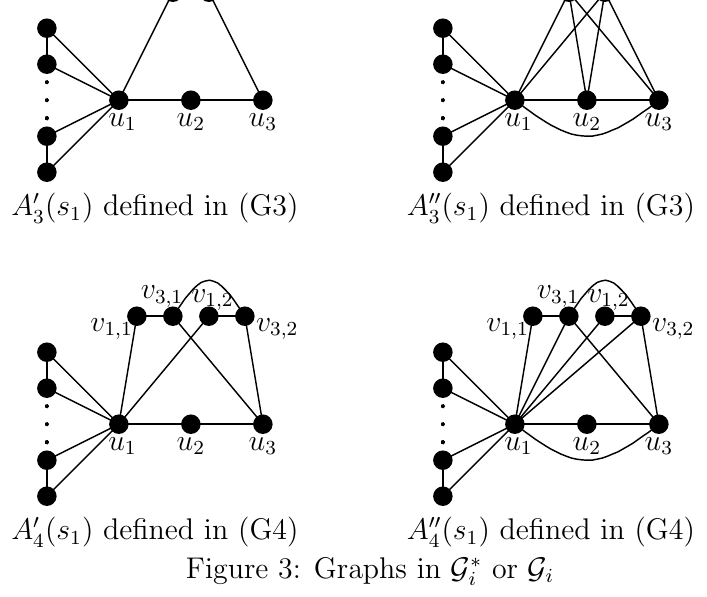
Figure 3: Graphs in G (cid:3)